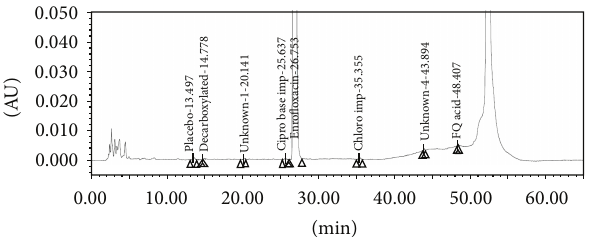
Figure 10: 1% impurities spiked sample at 254